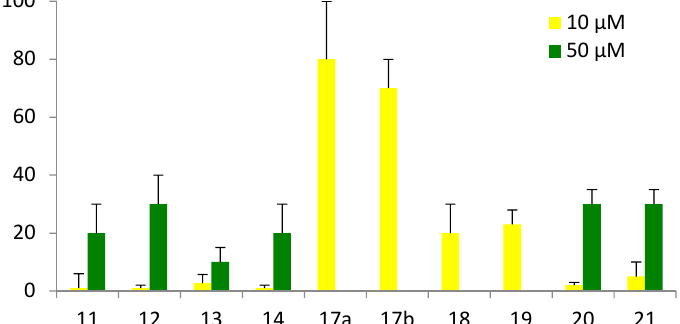
Figure 6. Percentage of hemolysis (see Supporting Information). The given results correspond to a percentage calculated as follows: %age = absorbance obtained with the peptide - absorbance obtained with the negative control (=buffer alone)/absorbance obtained with the positive control (=triton). * The haemolytic activities of peptides 17a , 17b , 18, and 19 were not measured at 50 µM because of their poor solubility at such concentration.